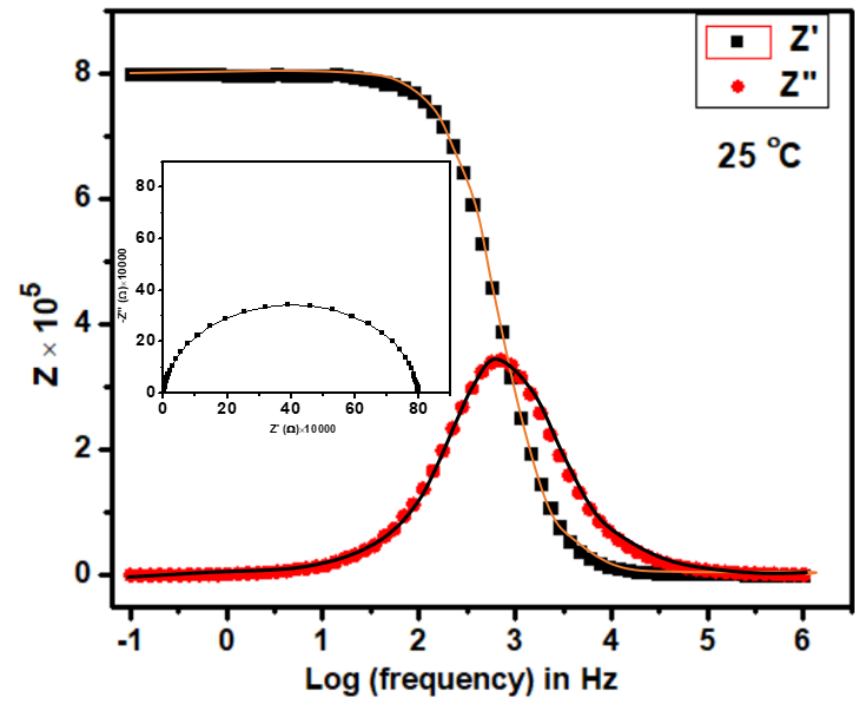
Figure 5. Variation of Z ’ and Z ” with frequency at 25 °C. Inset is the cole-cole plot at the same temperature for the compound Ca 2 Fe 2 O 5 .